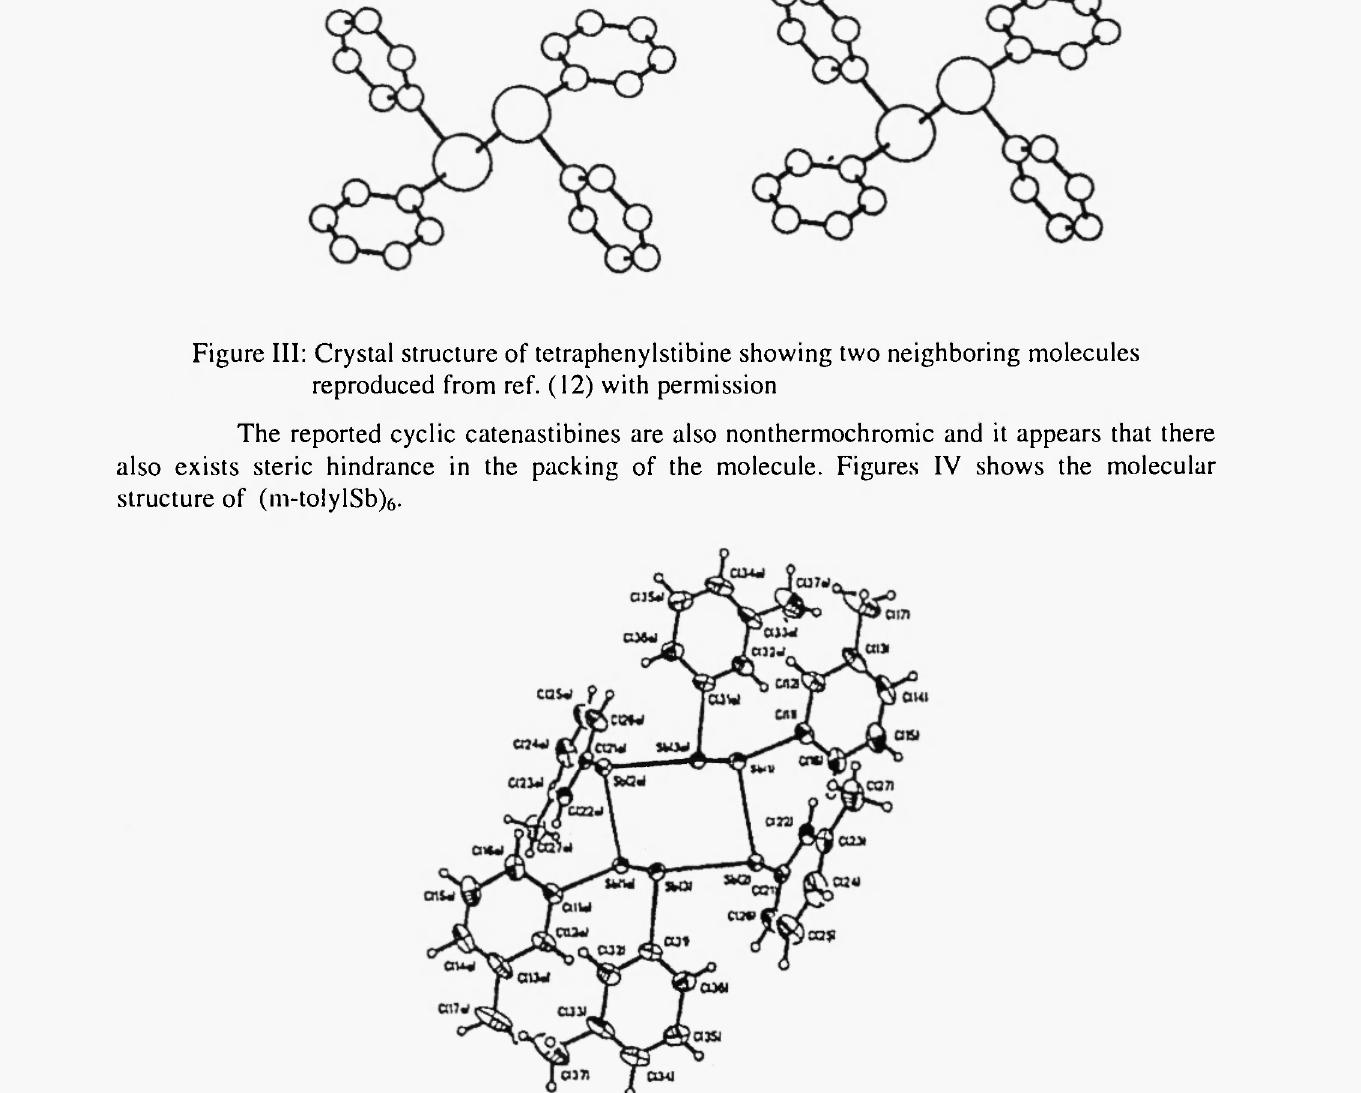
Figure IV: Molecular structure of (m-tolylSb) 6 reproduced from ref. (47) with permission